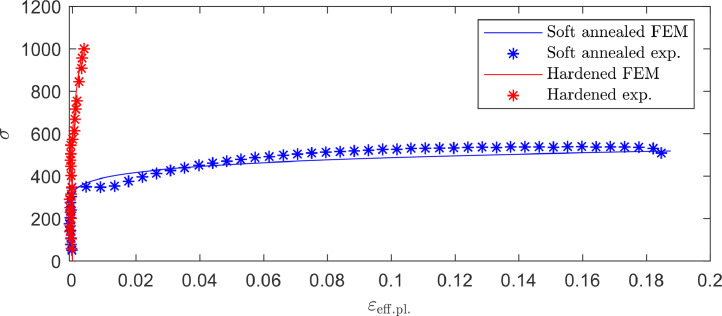
Tensile curves for SS142506.